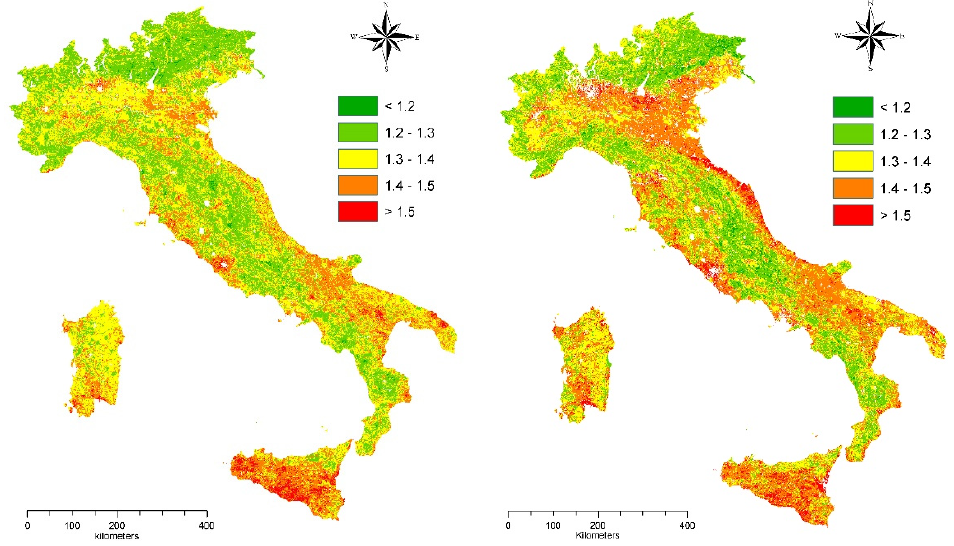
Figure 1. Spatial distribution of the Environmentally Sensitive Area Index (ESAI) in Italy ( left : 1960; right : 2010).